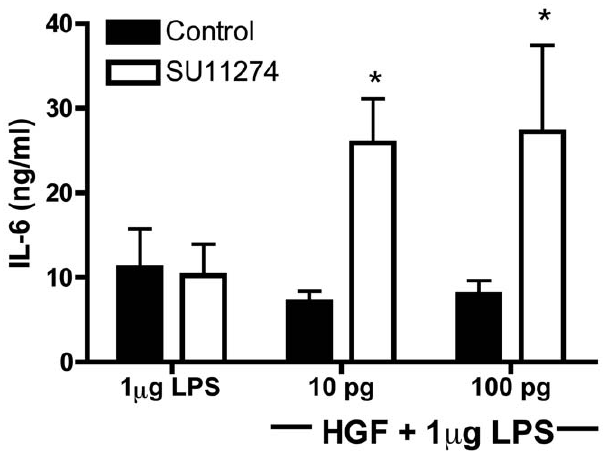
Figure 2. A MET kinase inhibitor abrogates HGF suppression of IL-6. Using an optimal dose of the MET inhibitor SU11274 (1 m g), BMM were pretreated for 2 hours before an overnight incubation with 10 and 100 pg HGF and 24 hour stimulation with LPS. Results are represen- tative of the mean ( 6 SEM) of three independent experiments done in triplicate. *, p=0.02 vs. the respective control group.